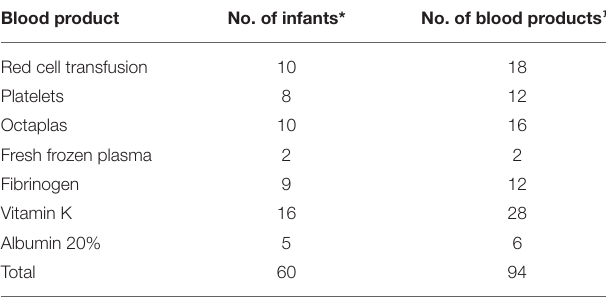
TABLE 1 | Blood products requirements in infants with